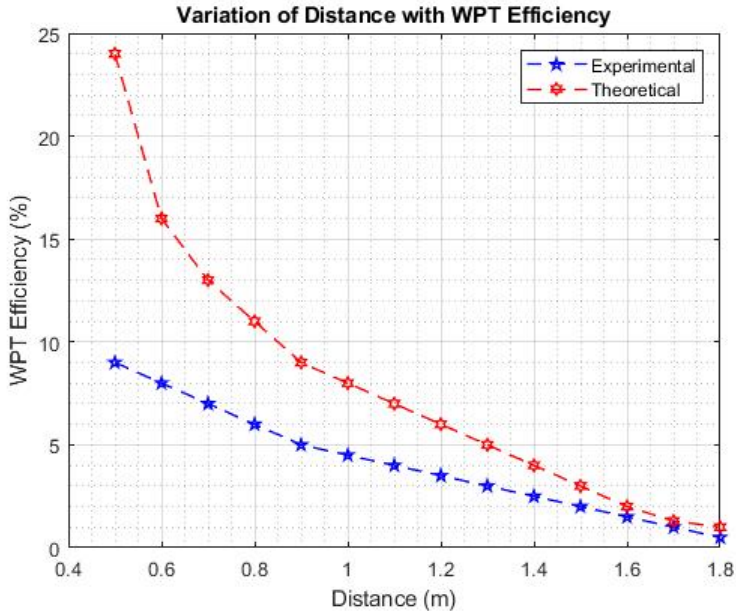
Figure 5. Effect of varying distances on WPT efficiency .